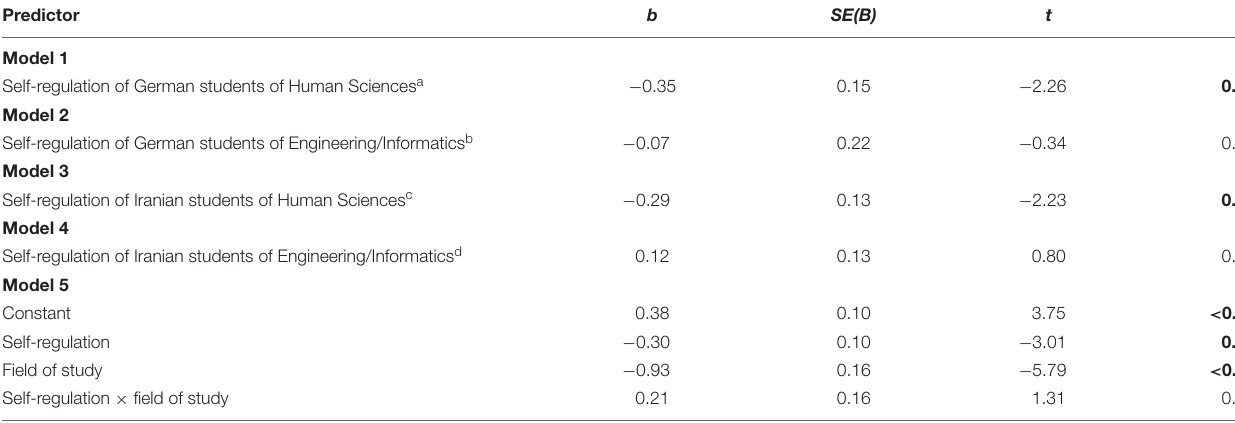
TABLE 3 | Regression analysis predicting multiplication RT from self-regulation in German and Iranian students of Human Sciences and Engineering/Informatics. Predictor b SE(B)